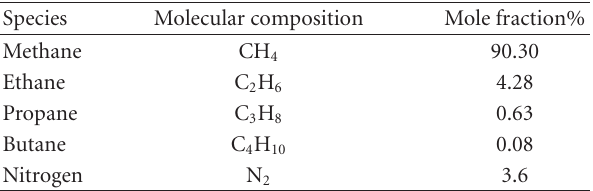
Table 2: Natural gas composition used in DF engine.